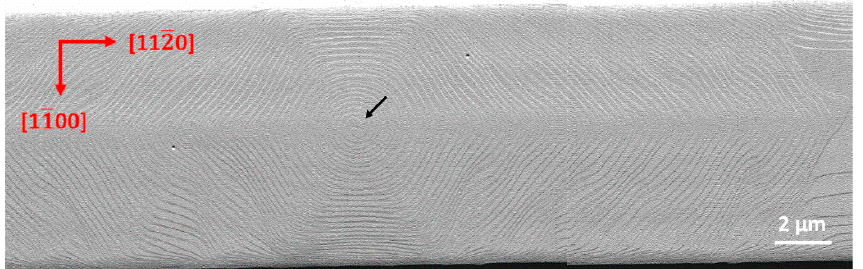
Figure 3. AFM amplitude images (30 × 10 μ m 2 ) on the stripes along the a-direction of sample A. The black arrow points to the apex of a screw dislocation.